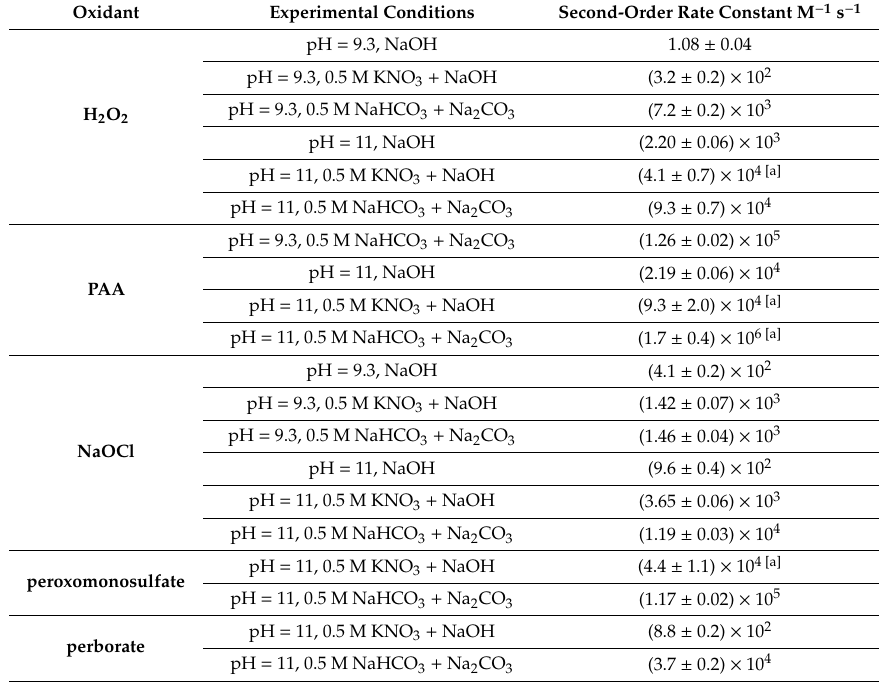
Table 1. Rate constants for the oxidation of Mn III (TPPS) by studied oxidants at 25 ◦ C. Oxidant Experimental